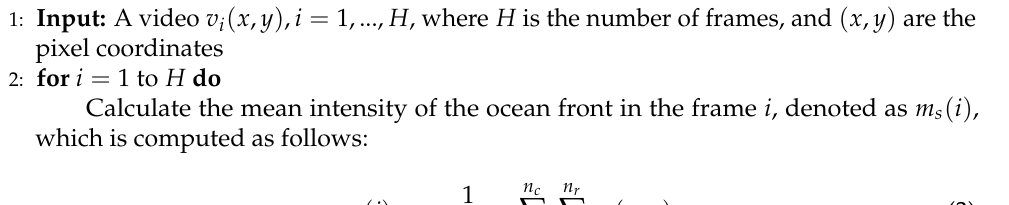
Algorithm 1 Classification Algorithm Based on Strength